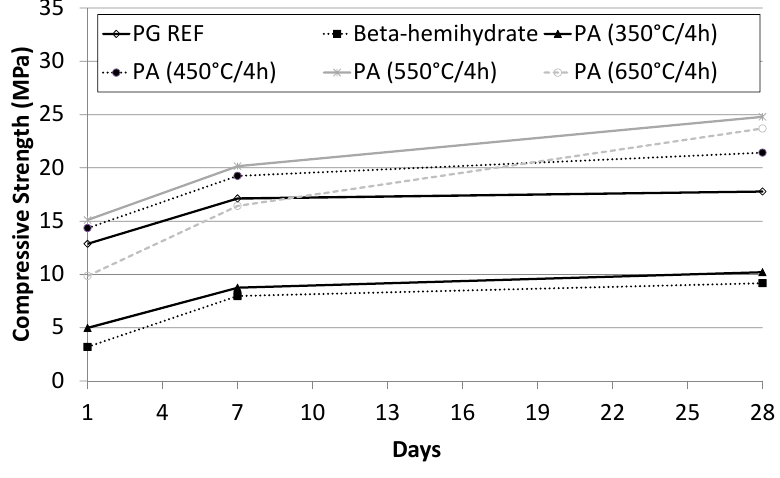
Figure 7. Compressive strength of SLU samples over 28 days.